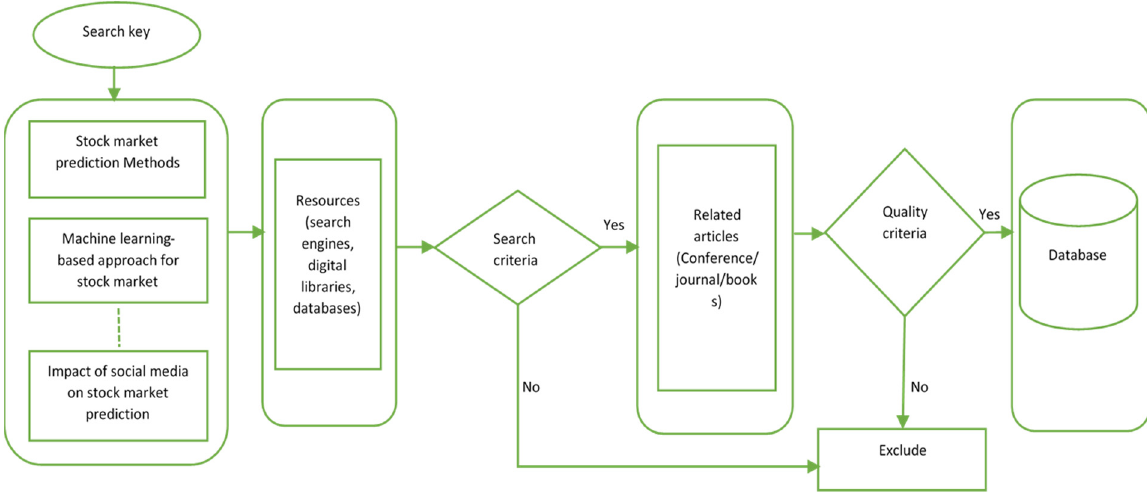
Figure 2. Literature collection process.